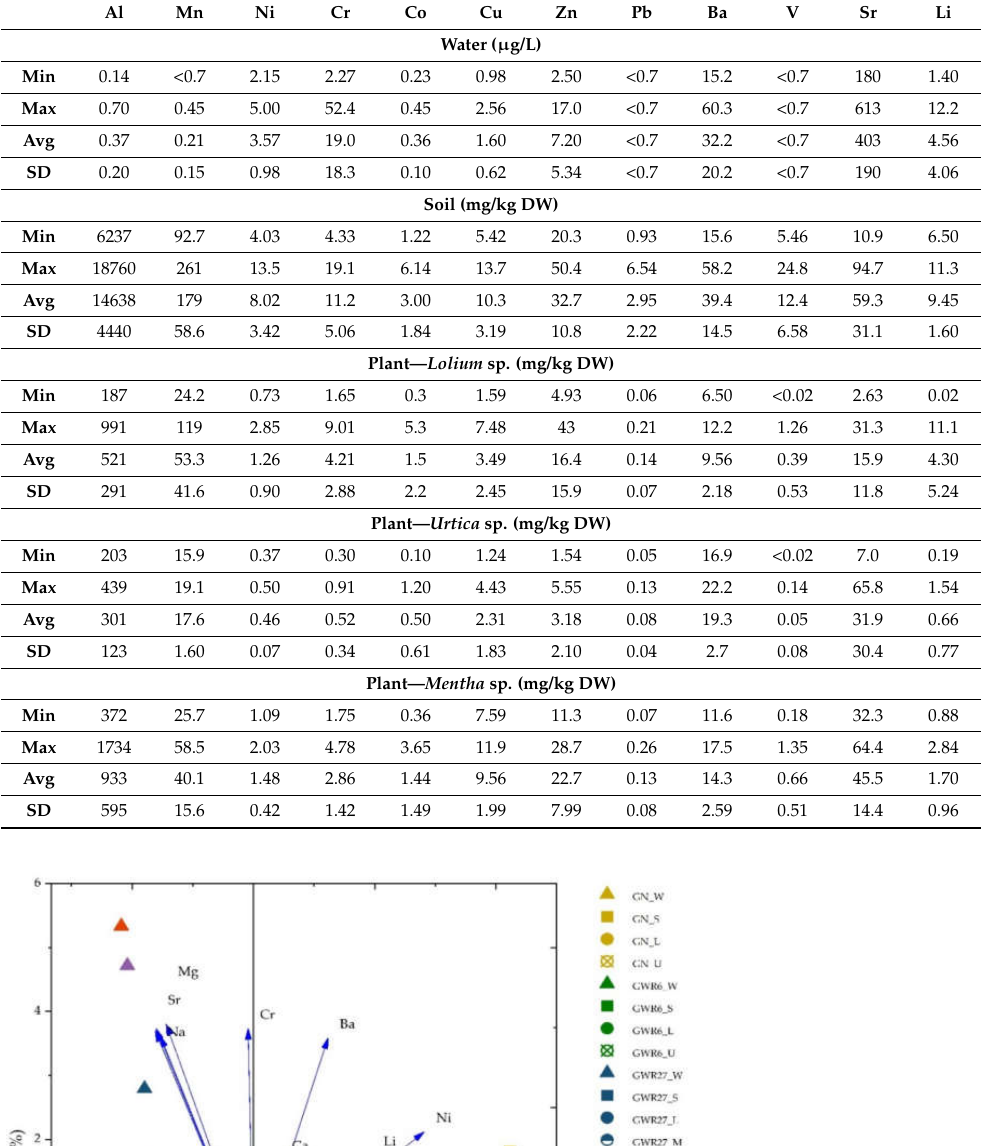
Table 5. Maximum (Max), minimum (Min), average (Avg), and standard deviation (SD) of microele-